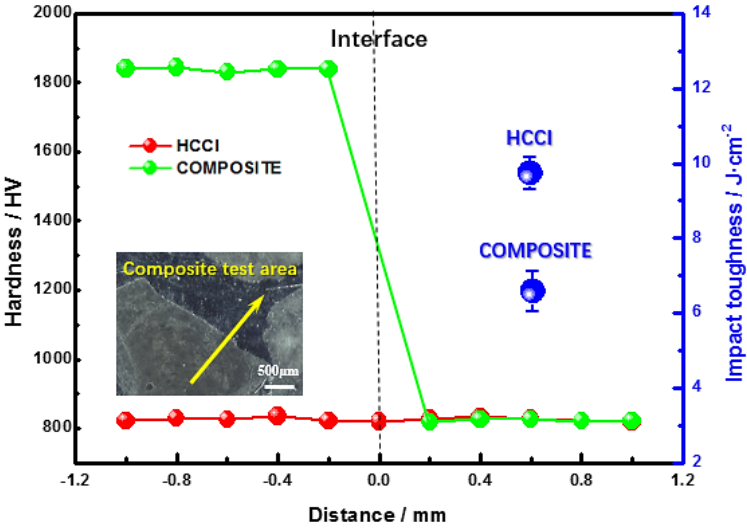
Figure 5. Microhardness and impact toughness results of the HCCI (high chromium cast iron) and composite.